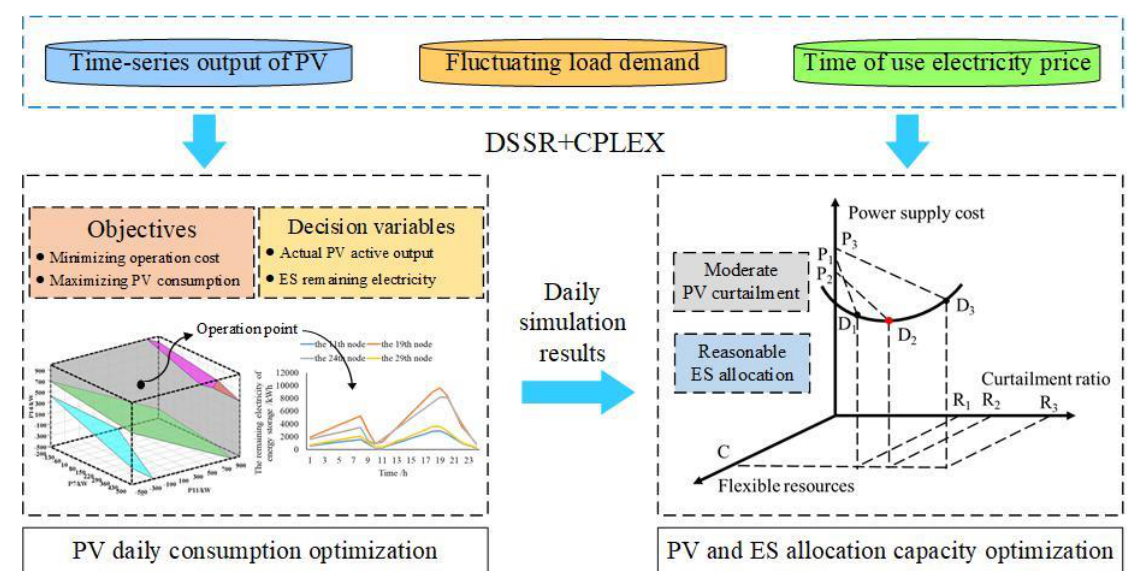
Figure 1. Schematic diagram of DG and ES optimization